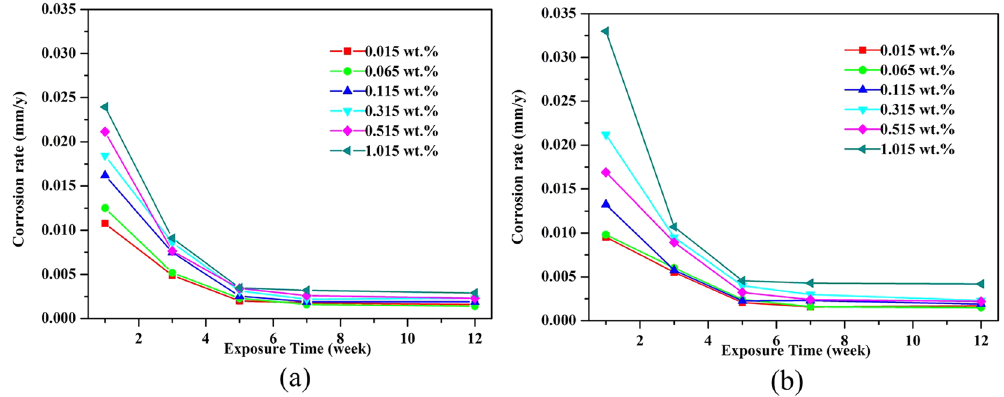
Figure 6. Corrosion rates of ductile iron ( a ) and carbon steel ( b ) after being exposed in soils with different levels of chloride.